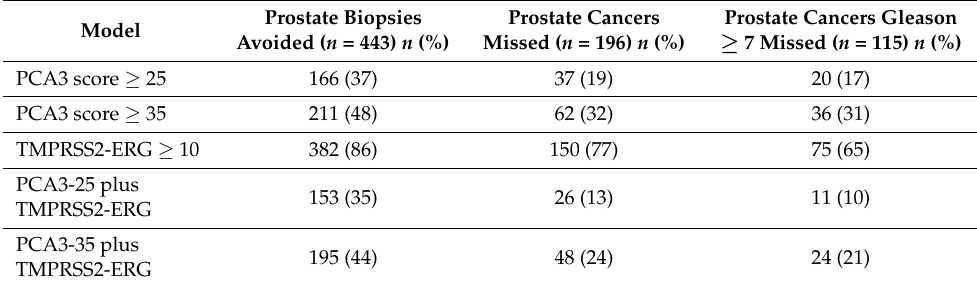
Table 3. Clinical implications of PCA3 plus TMPRSS2-ERG assays (adapted from [56]).